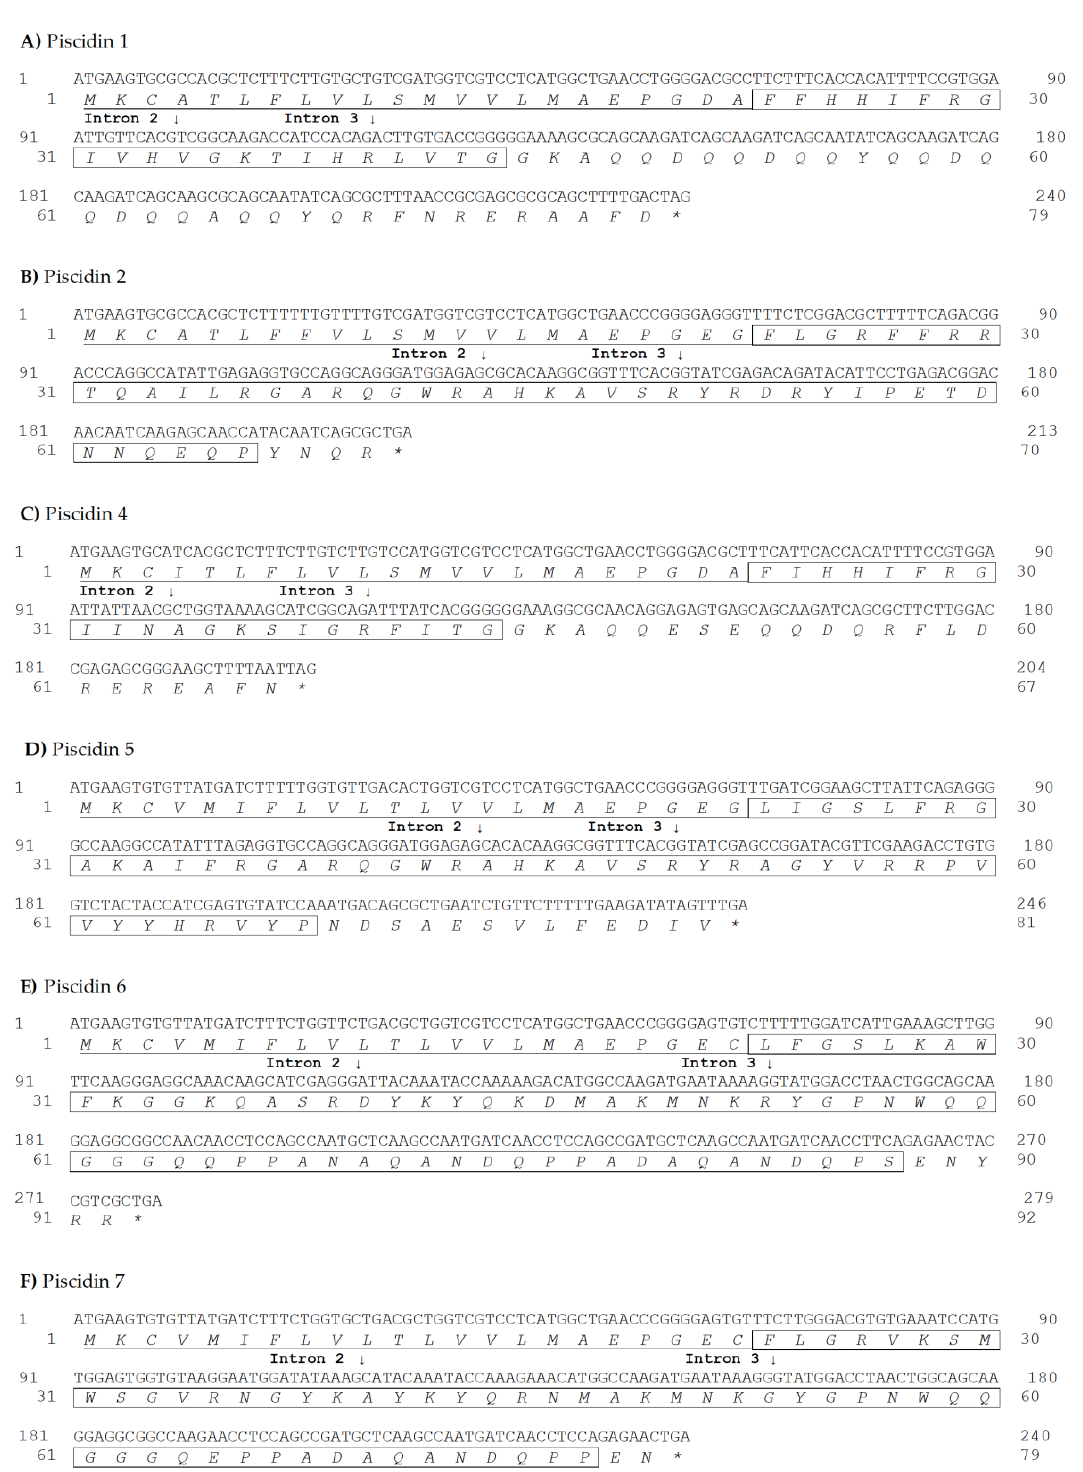
Figure 1. Sea bass piscidins coding DNA and amino acid sequences. Piscidin 1 ( A ), piscidin 2 ( B ), piscidin 4 ( C ), piscidin 5 ( D ), piscidin 6 ( E ) and piscidin 7 ( F ). Nucleotides are indicated in the upper row, and amino acids are indicated in italic in the lower row. Signal peptides are underlined and mature peptides are boxed. Intron positions are indicated by arrows.